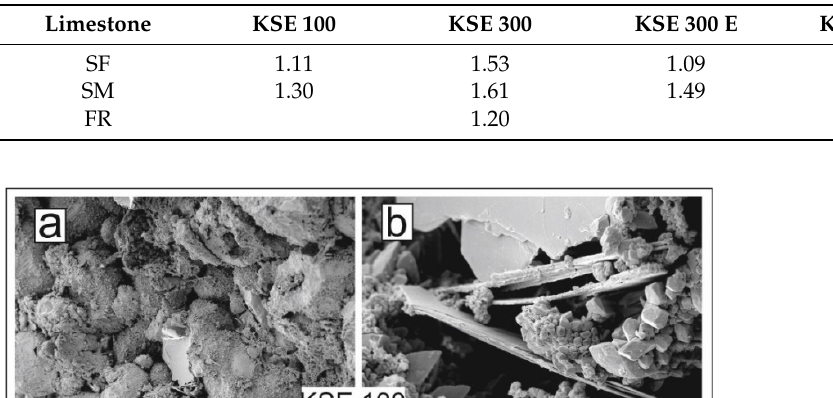
Table 5. Change in tensile strength after consolidation (ratio of consolidated and unconsolidated tensile strength).